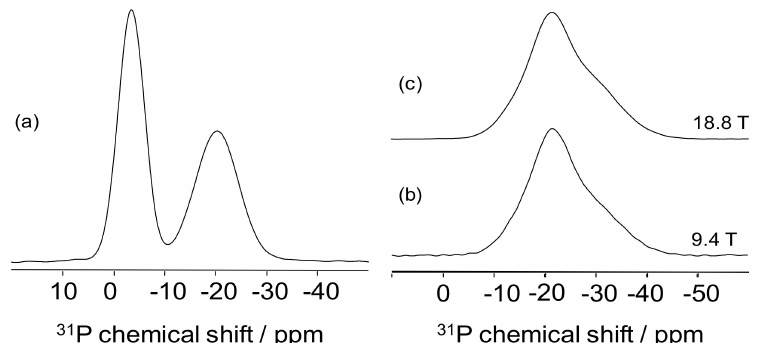
Figure 5. 31 P-MAS-NMR spectra obtained ( a ) on a lithium phosphate at 9.4 T and ( b , c ) on lithium boro-phosphate glasses at ( b ) 9.4 T and ( c ) 18.8 T.